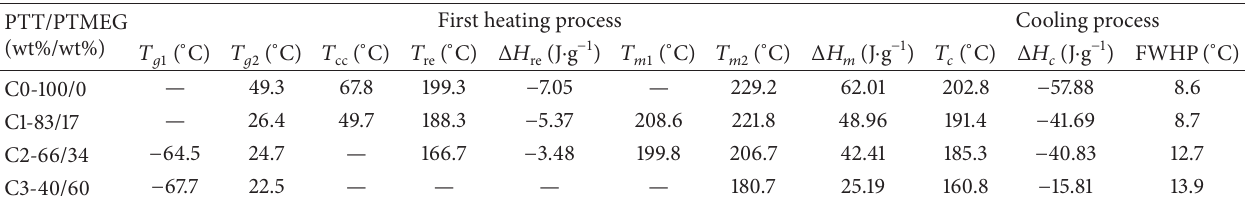
Table 3: DSC melting and crystallization parameters of the various